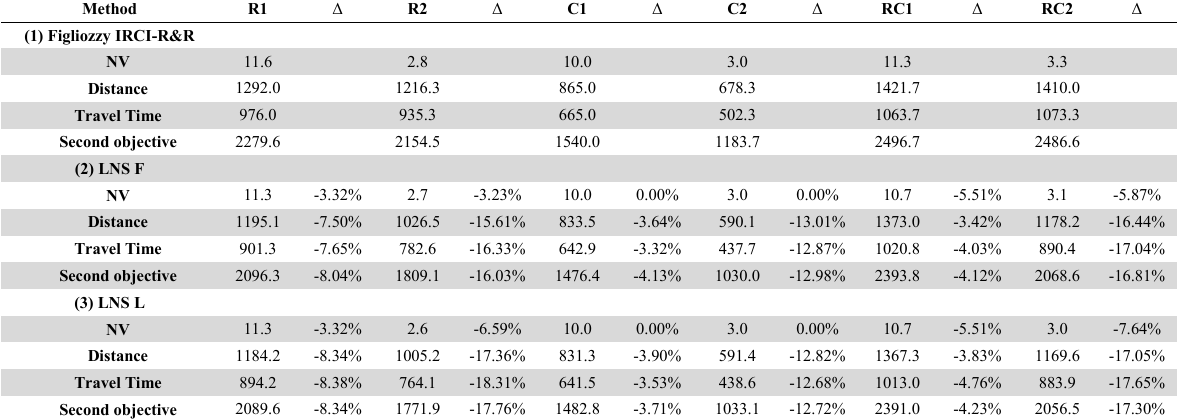
TDVRPTW Average results for 3 instances in Cases Type (d) 100 customers